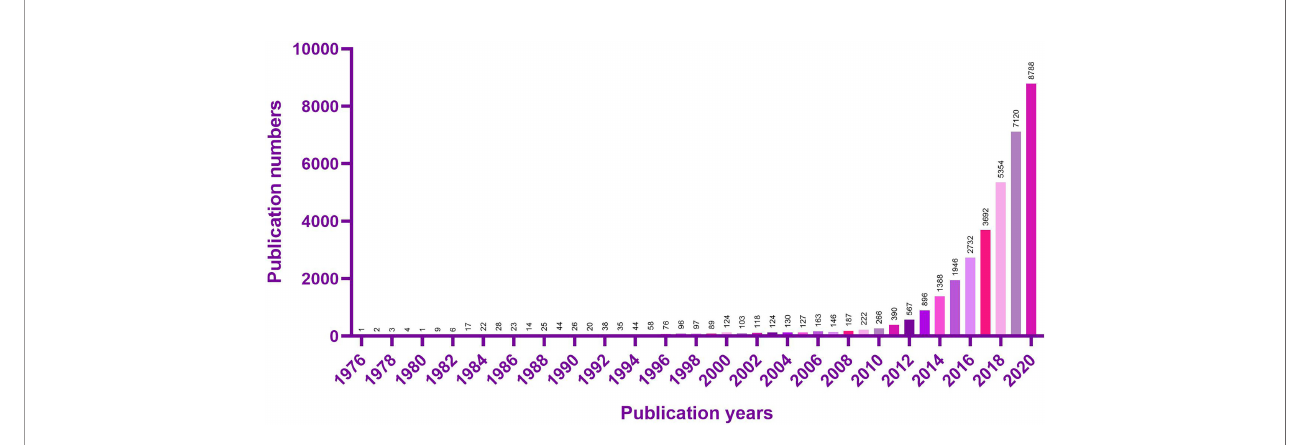
FIGURE 1 | PubMed search results using the keyword “ LncRNA ” are displayed as a